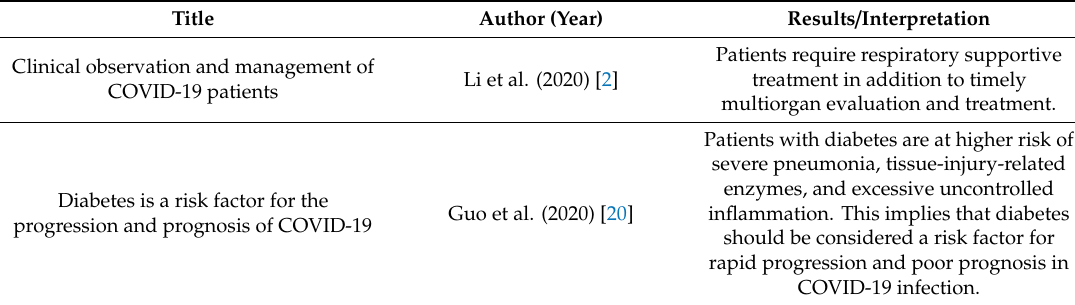
Table 1. Summary of recent research on Furin, Osteopontin, diabetes, and angiotensin-converting enzyme 2 (ACE2) as related to corona virus disease 2019